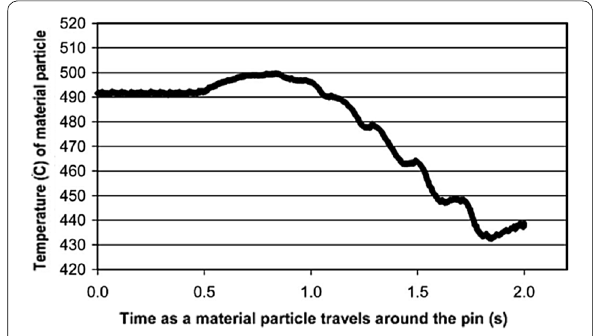
Figure 25 Temperature history for the particles of the material near the pin [27]